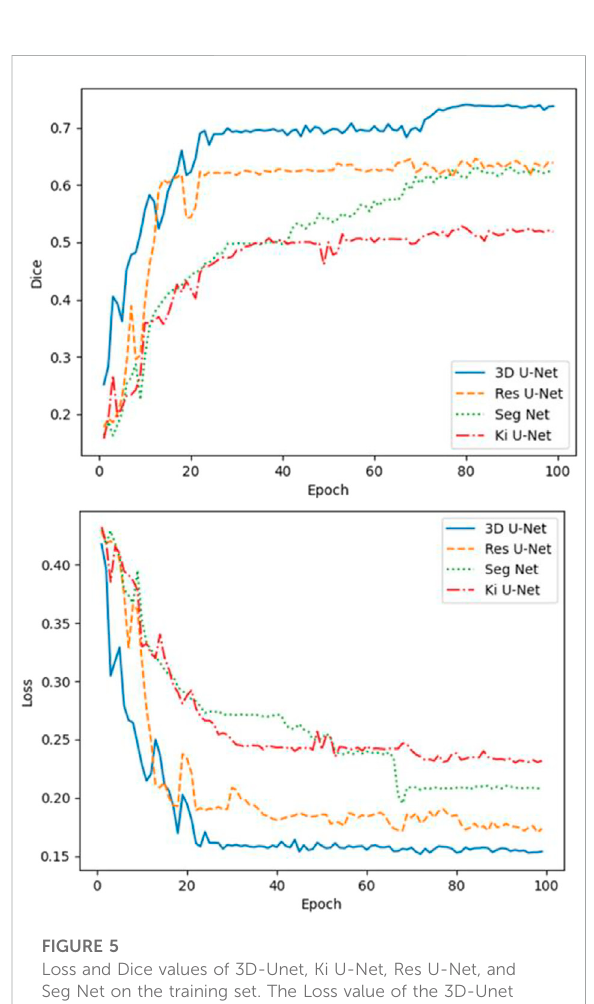
FIGURE 5 Loss and Dice values of 3D-Unet, Ki U-Net, Res U-Net, and Seg Net on the training set. The Loss value of the 3D-Unet algorithm is lower than the other three algorithms, while the Dice value is higher than the other three